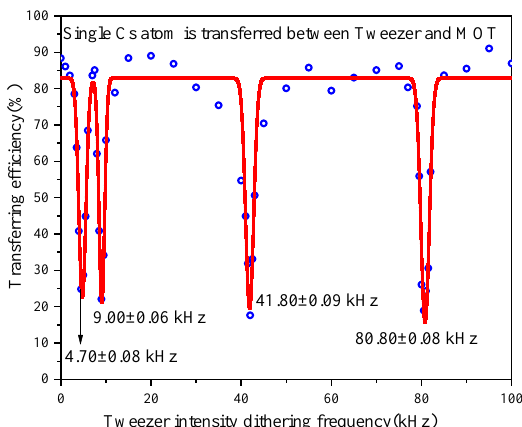
Figure 7. Trap frequency and double frequency of the 1064-nm optical tweezer. Transfer efficiency goes an apparent decline when the modulation frequency is resonant or near-resonant to the trap frequency and its double frequency of the optical tweezer and reaches a minimum at resonance.